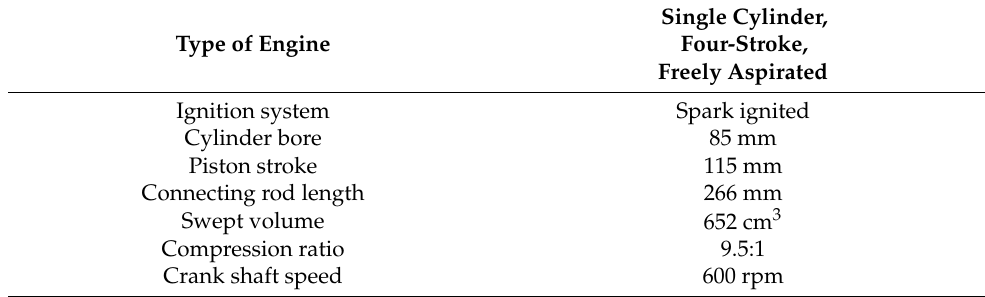
Table 4. Specifications of the engine UIT-85.